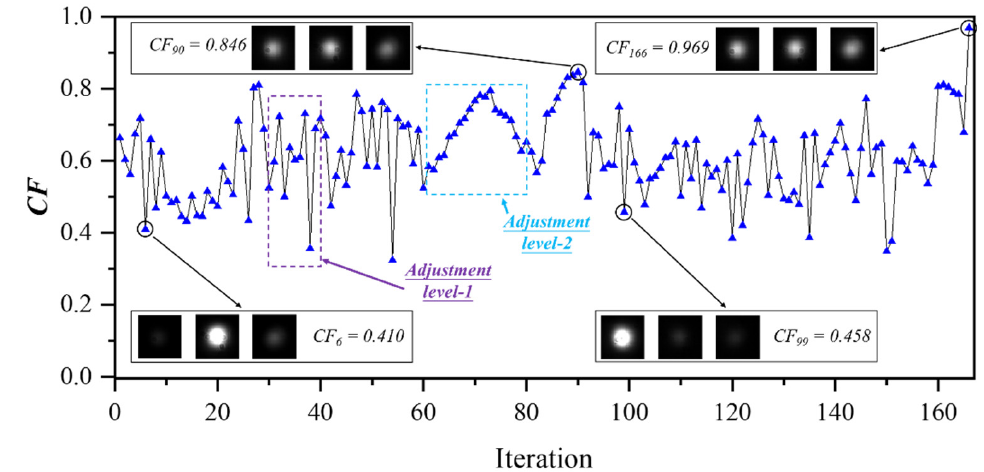
Figure 8. The relationship between the cost function and the iteration numbers for the case [0.33:0.33:0.33] . Insets are the actual shot photos of the intermediate results (No. 6, 90, 99) and the final result (No. 166).